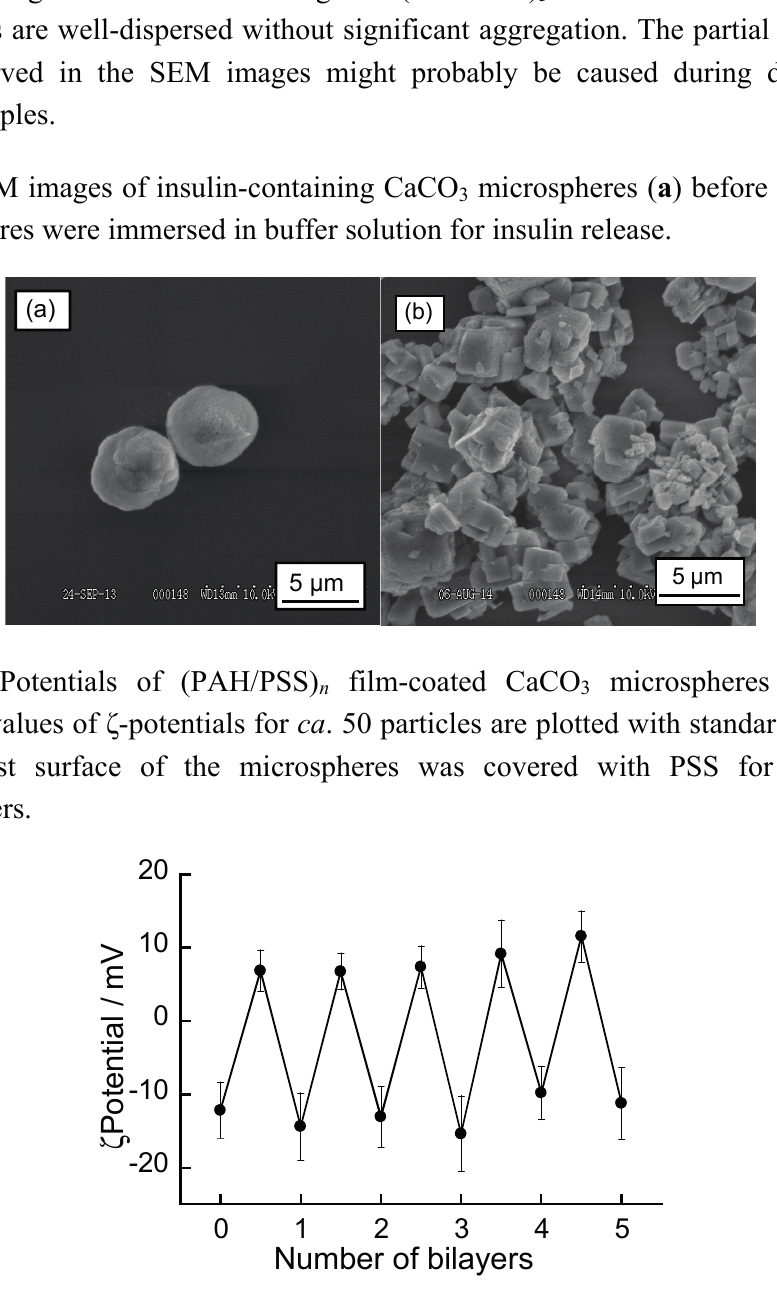
microspheres ( a ) before and ( b ) after 3